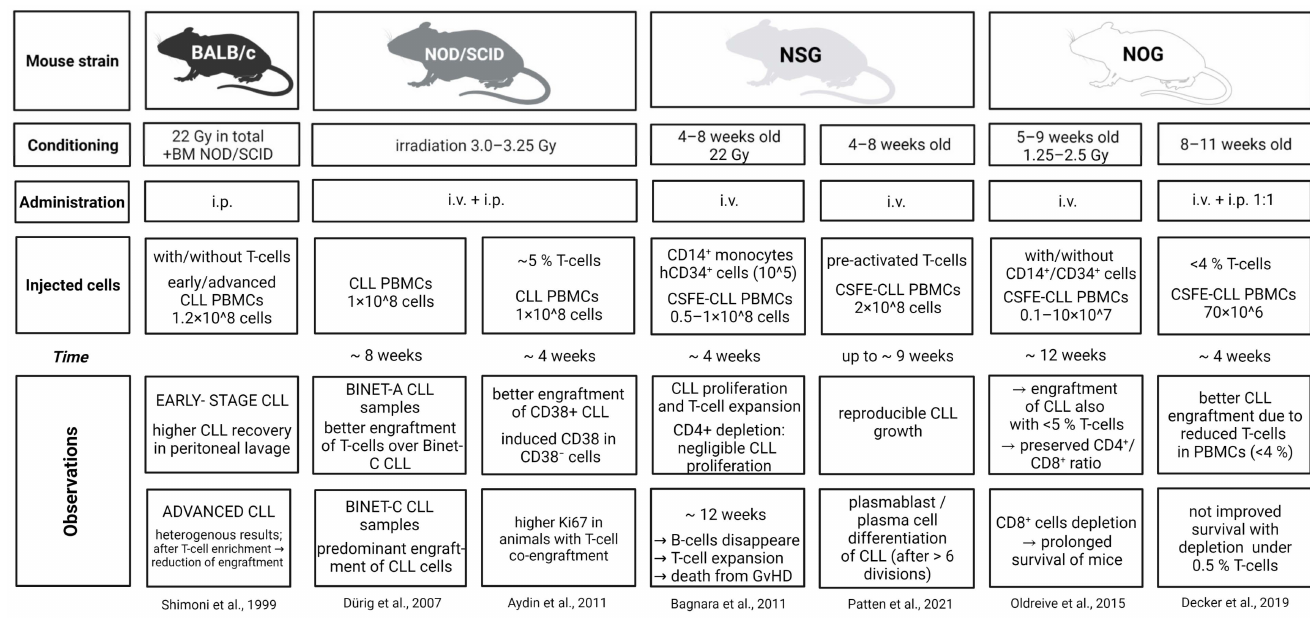
Figure 4. Murine models revealing role of T cells in CLL biology. BM = bone marrow, CSFE = carboxyfluorescein succinimidyl ester, PBMC = peripheral blood mononuclear cells